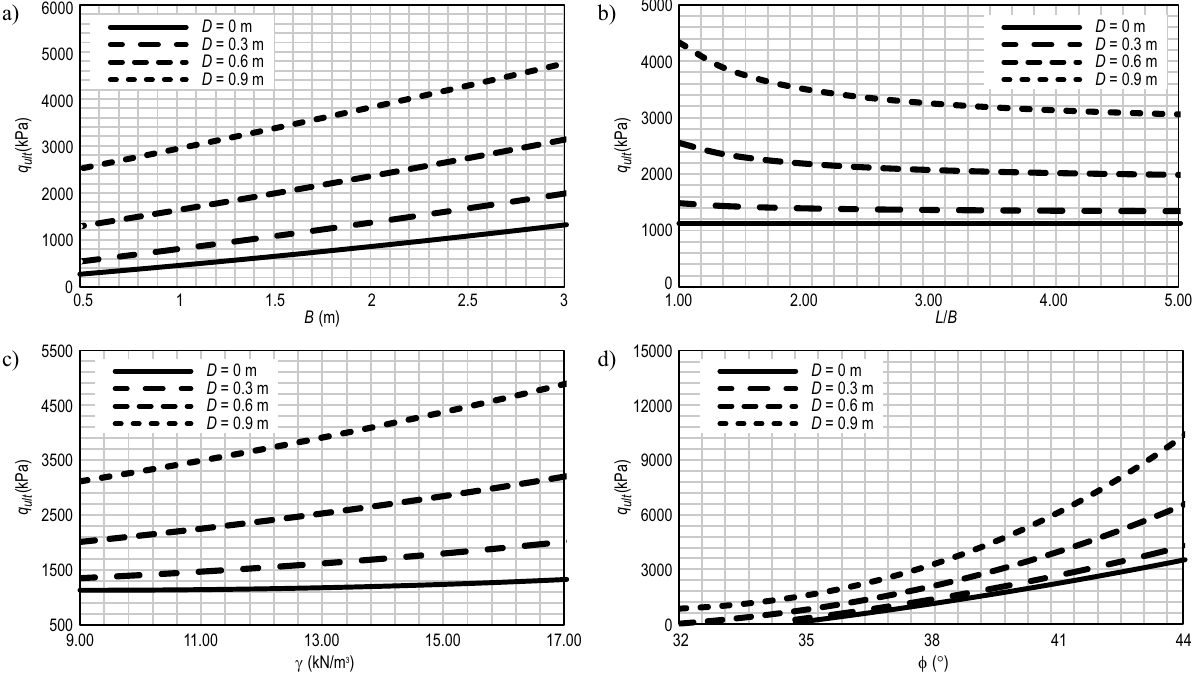
Fig. 10. Parametric analysis of q ult in the LGP